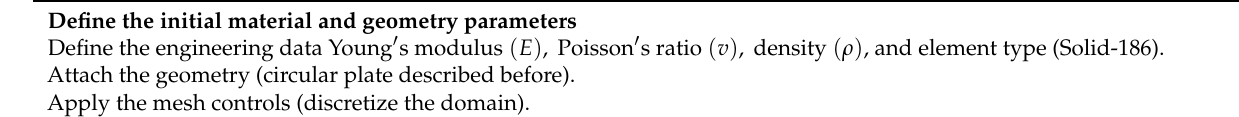
Table A1. Stages of FEM implementation in